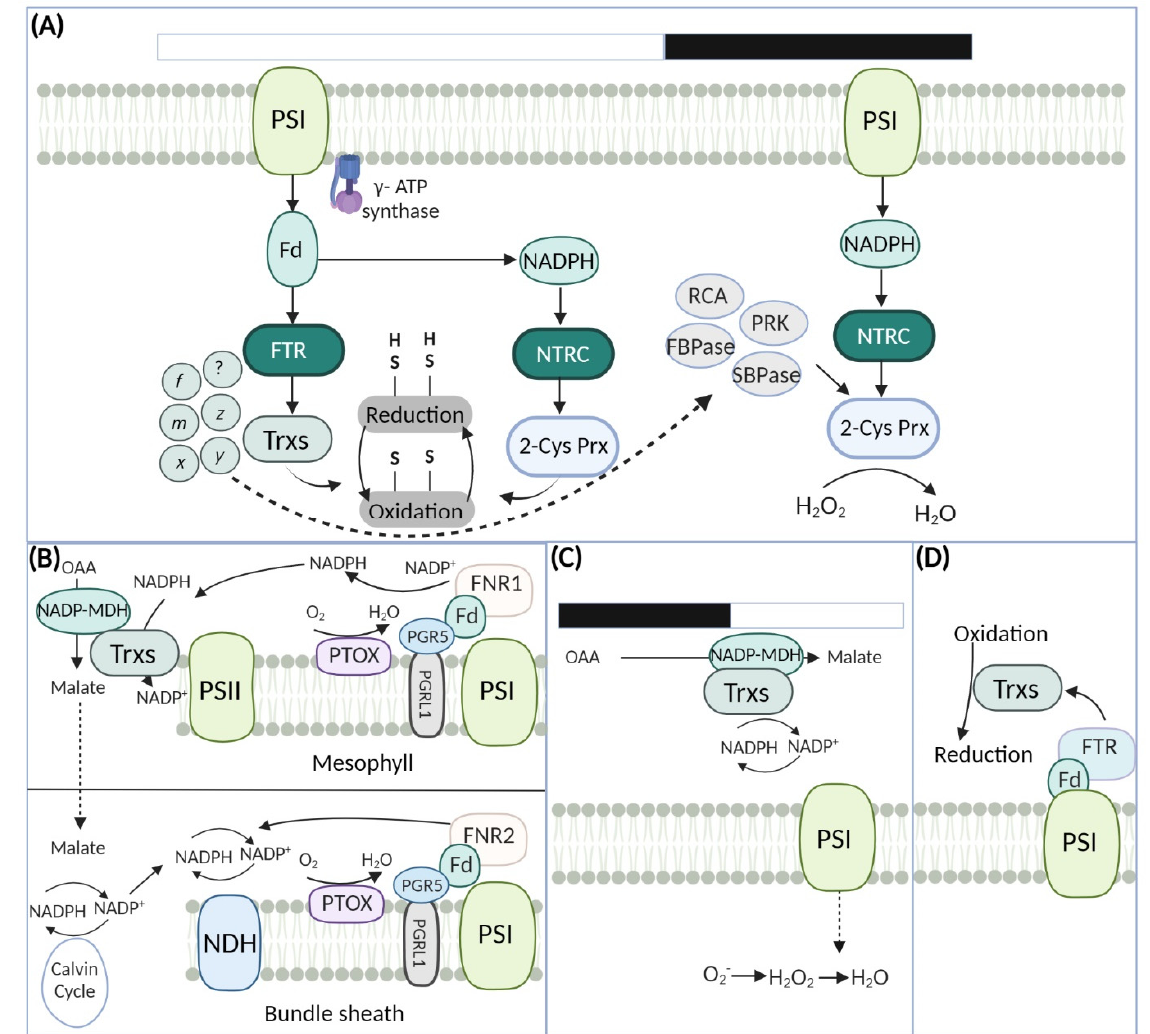
Figure 4. Redox signaling in evolutionary distinct photosynthetic machinery. Light and dark periods activate and deactivate the target photosynthesis enzymes. ( A ) Calvin-Benson Cycle ( B ) Kranz anatomy ( C ) CAM photosynthesis ( D ) Early divergent land plants and green algae. Trx-like proteins carry oxidation and reduction reactions to maintain PSI homeostasis. RCA: ribulose-1,5-bisphosphate carboxylase/oxygenase activase; FBPase: fructose-1,6-bisphosphatase; SBPase: sedoheptulose-1,7-bisphosphatase; PRK: phosphoribulokinase; PSI: photosystem I; PQ: plastoquinone, PTOX: plastid terminal oxidase; PGR5-PGRL1: 5-PGR5-like photosynthetic phenotype 1; FNR: ferredoxin; NADPH reductase; Fd: ferredoxin.